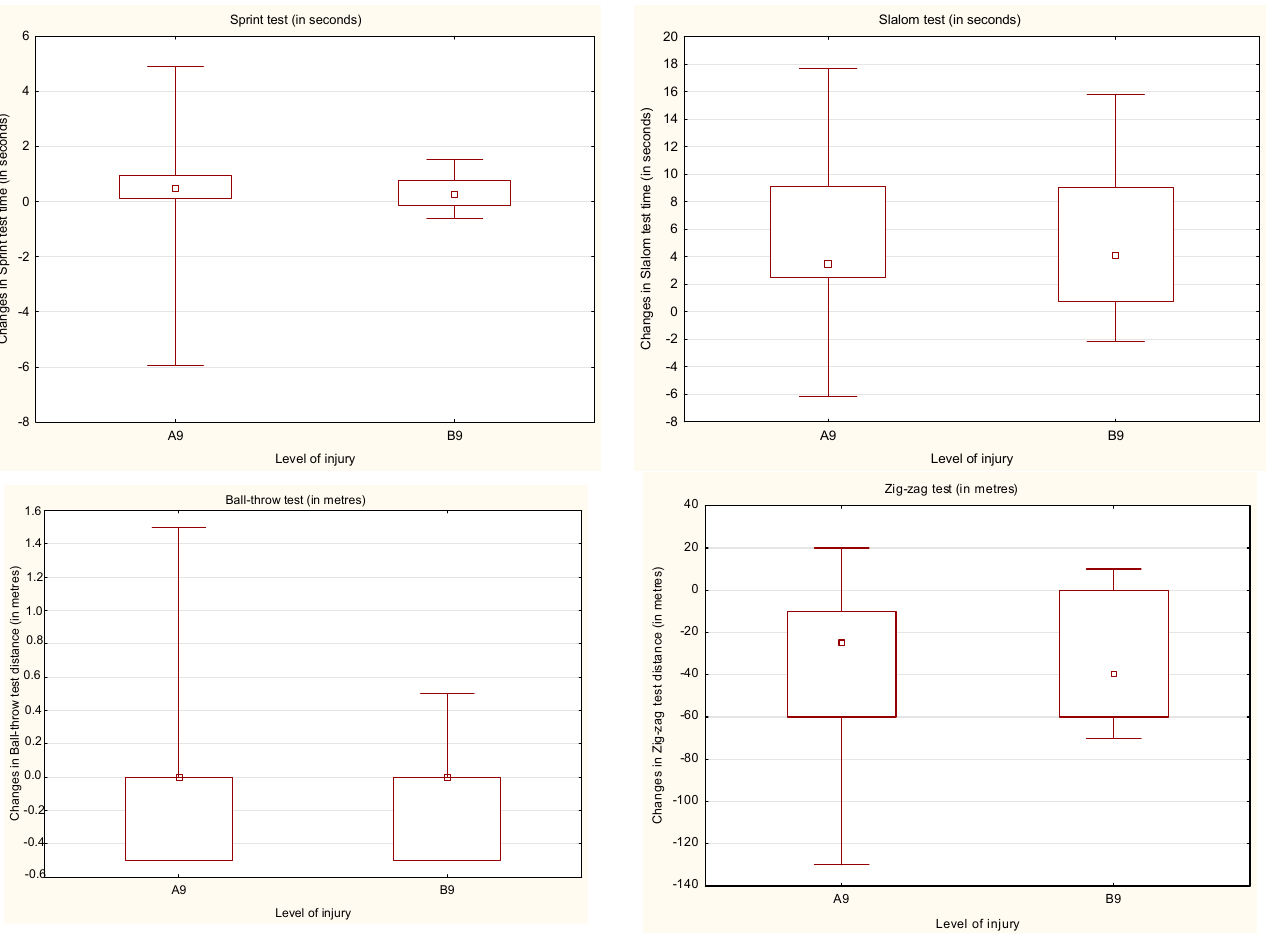
Figure 3. The changes in the results obtained before and after the ARC by the participants according to the level of injury. A9—above Th-9; B9—below Th-9.